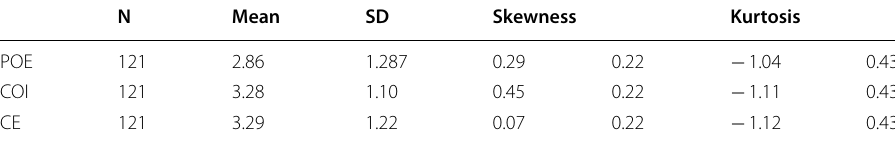
Table 5 Descriptive statistics for L2 grit (POE & COI), and CE in private institute learners N Mean